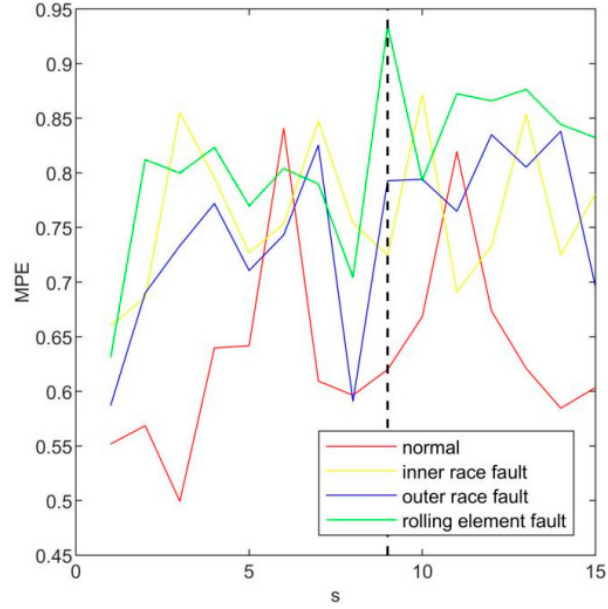
Figure 8. The MPE of imf2.